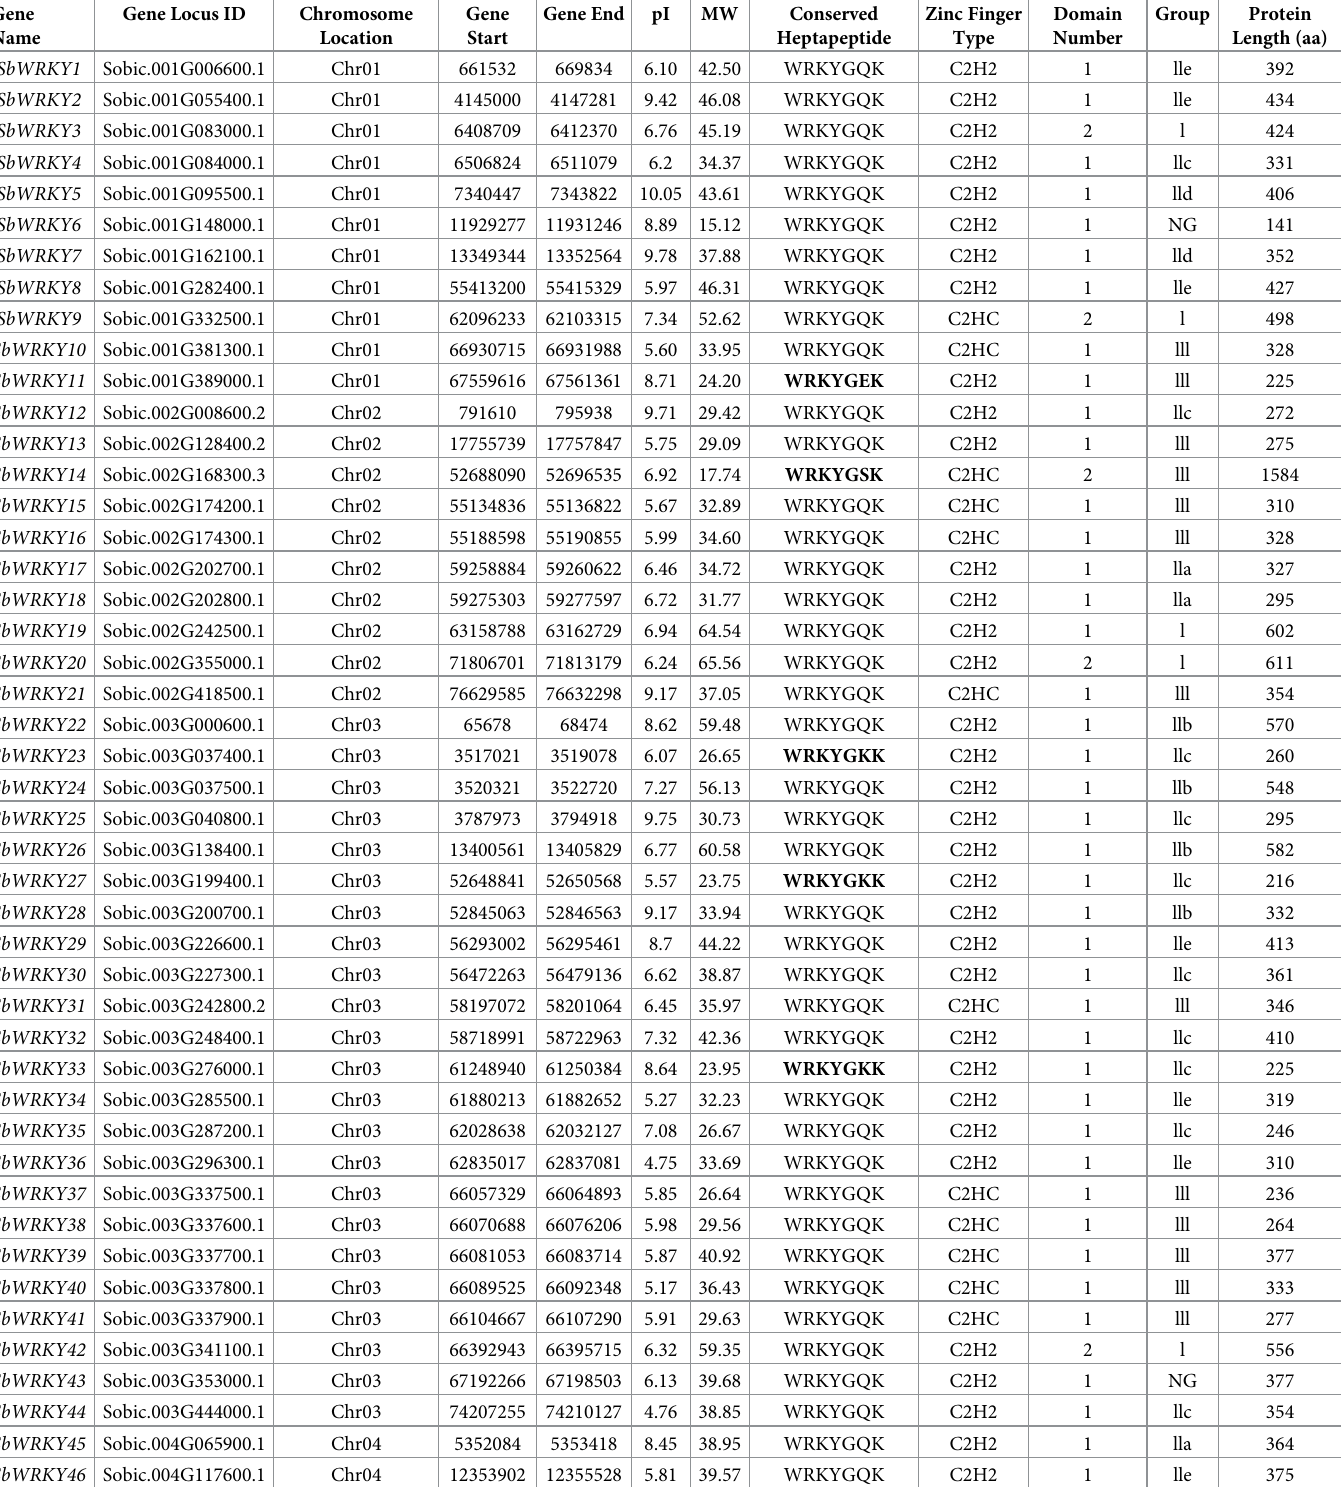
Table 1. Characteristics of the identified SbWRKY